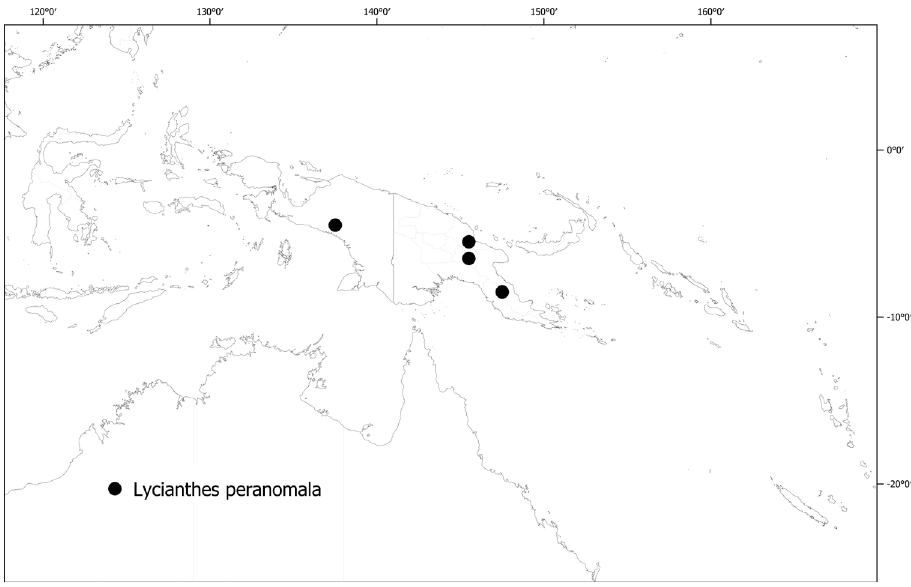
Figure 42. Distribution of Lycianthes peranomala